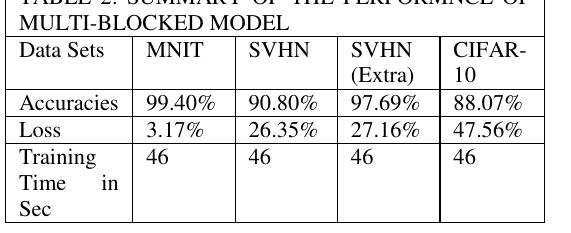
TABLE 3: COMPARISON MINIST DATA